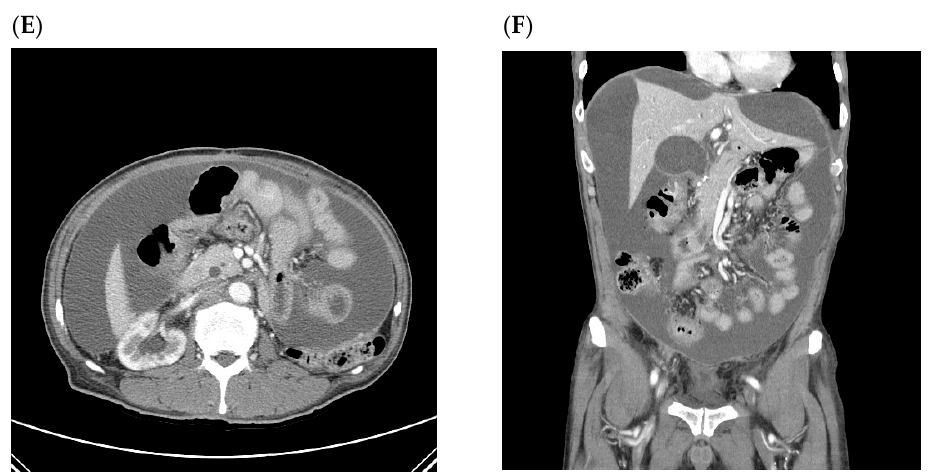
Figure 1. Typical ascites imaging in CT: ( A ) benign small pelvic ascites; ( B ) malignant small pelvic ascites with peritoneal thickening; ( C ) benign moderate ascites in perisplenic area (left abdomen); ( D ) malignant moderate ascites; and ( E , F ) alignant large ascites. Yellow stars indicate ascites.